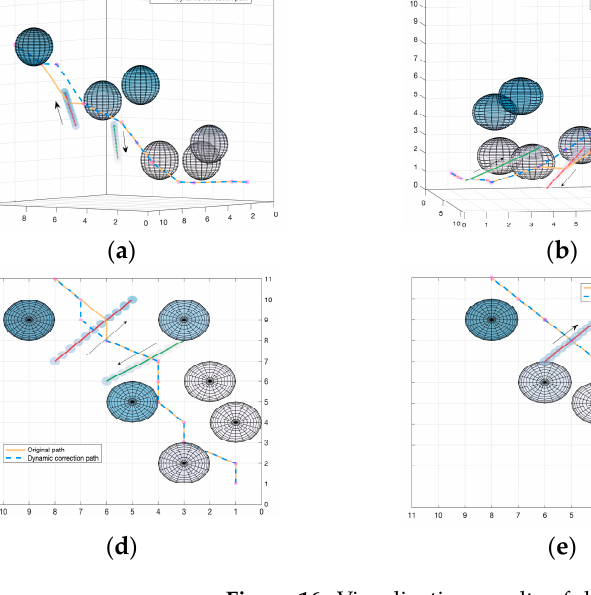
Figure 16. Visualization results of dynamic obstacle avoidance algorithm from a certain perspective ( a – c ) and top-down perspective ( d – f ).